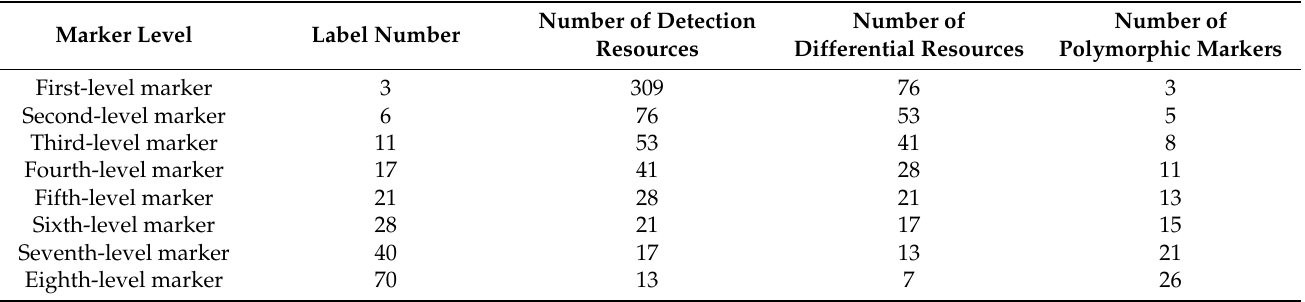
Table 5. Molecular detection results of 309 F 9 RILs derived from Gr 89-1 × Shuhui 527 by eight-grade